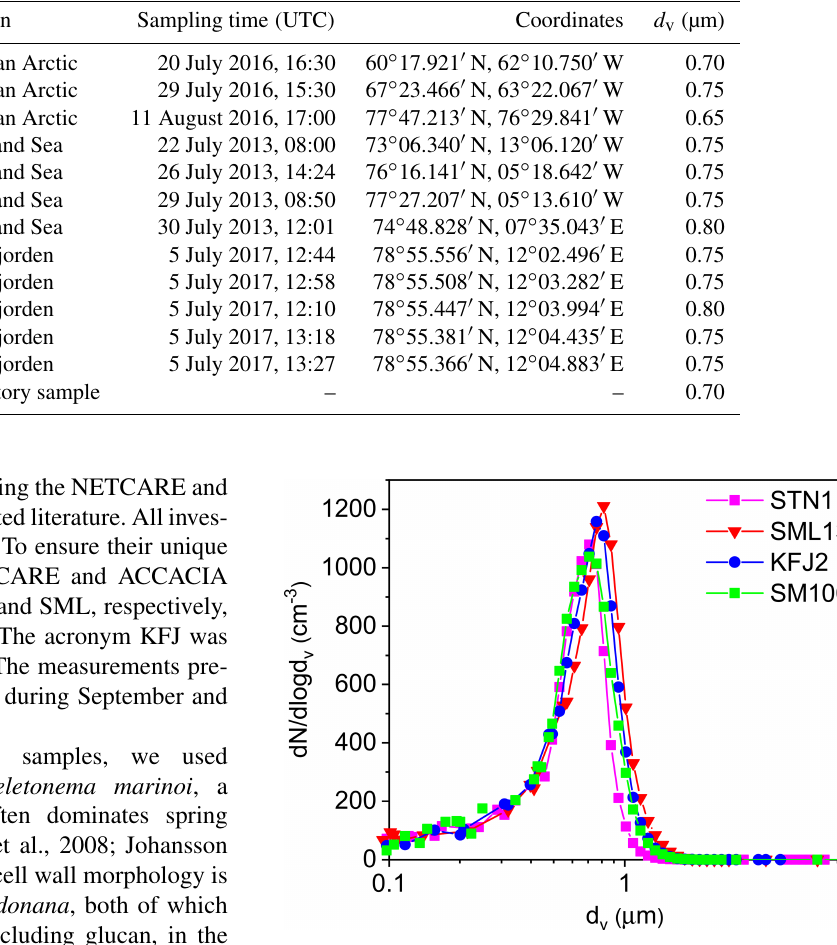
Figure 1. Number size distributions of aerosol particles generated by nebulising the STN1, SML13, KFJ2, and SM100 bulk solu- tions. The size spectra were measured at 298K and RH < 3%, thereby reflecting the dry particle diameters. The mobility and aero- dynamic diameters from the SMPS and APS measurements were converted into the equal-volume sphere diameter, d v , by assuming a dynamic shape factor of 1.08 (Hinds, 1999) and a particle density of 2.017gcm − 3 for sea salt (Zieger et al.,